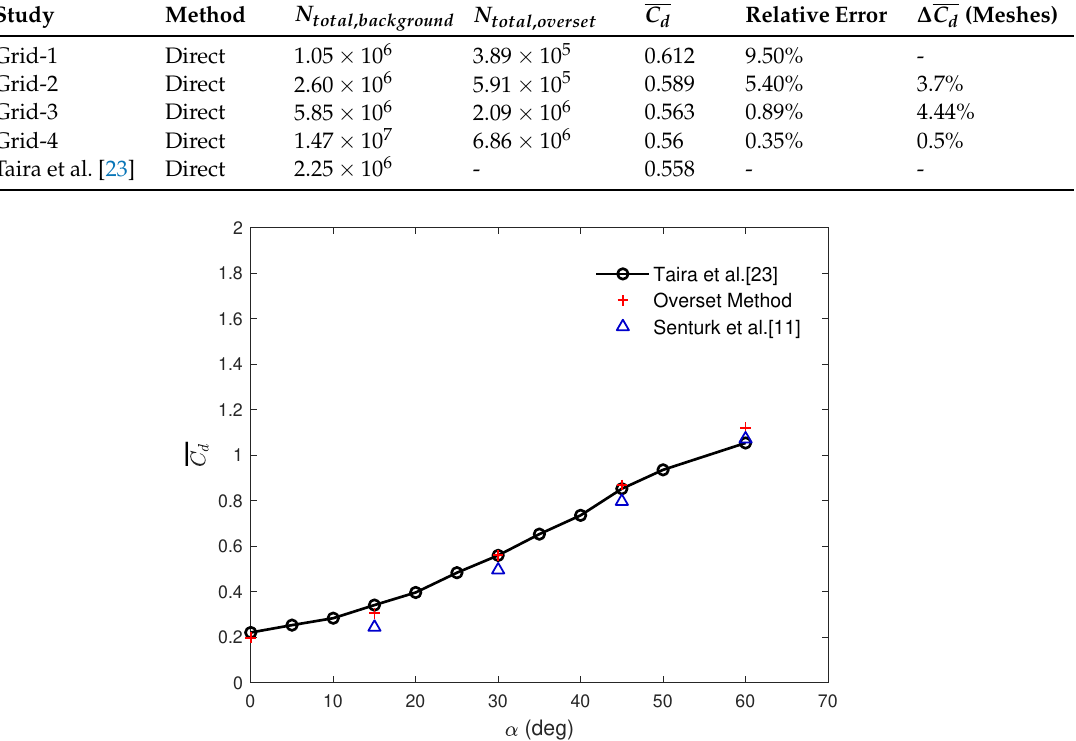
Figure 5. Variation of mean coefficient of drag ( C d ) with angle of attack ( α deg) for 3D stationary panel (Case 1–5).